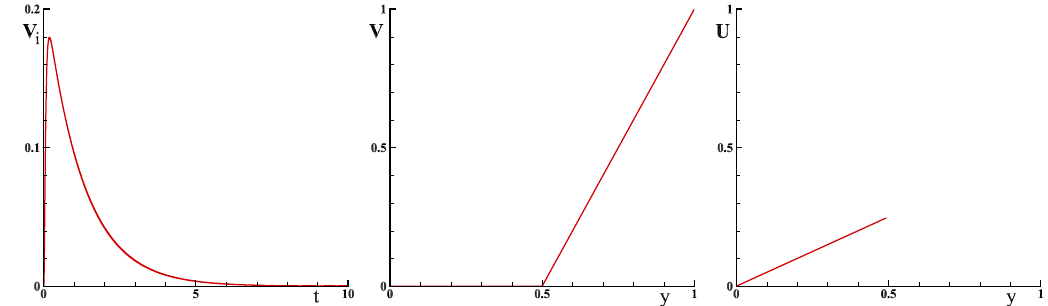
Figure 2. Fluid–structure interaction between a viscous fluid and an elastic solid; the viscosity of the fluid is equal to ν = 1 m 2 s − 1 and the solid shear modulus is equal to ν = 4 m 2 s − 1 : (left) the velocity of the interface over time is presented; (middle) the velocity V at steady-state regime is reported; and (right) the displacement of the solid U is